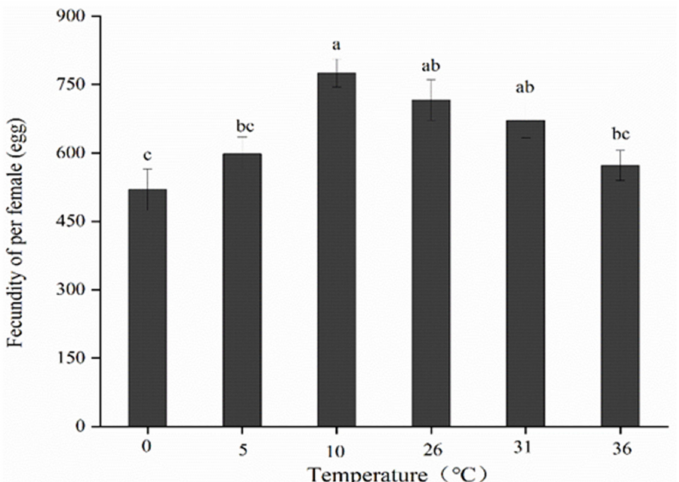
Figure 3. Fecundity of per female exposed to various short-term high- and low-temperature treat- ments. Different lowercase letters indicate significant differences among insects subjected to various temperature treatments ( p < 0.05, Tukey’s test). Data are expressed as means ± standard errors of four replicates.